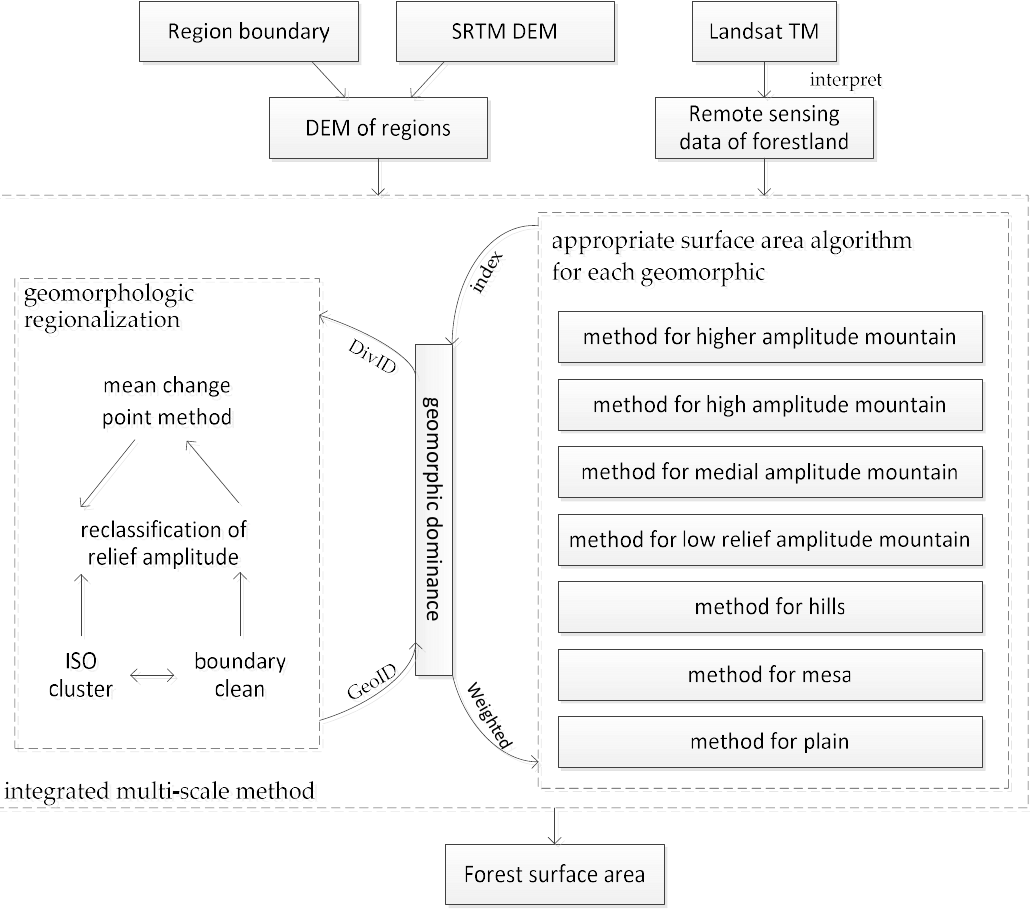
Figure 1. Technical routes.